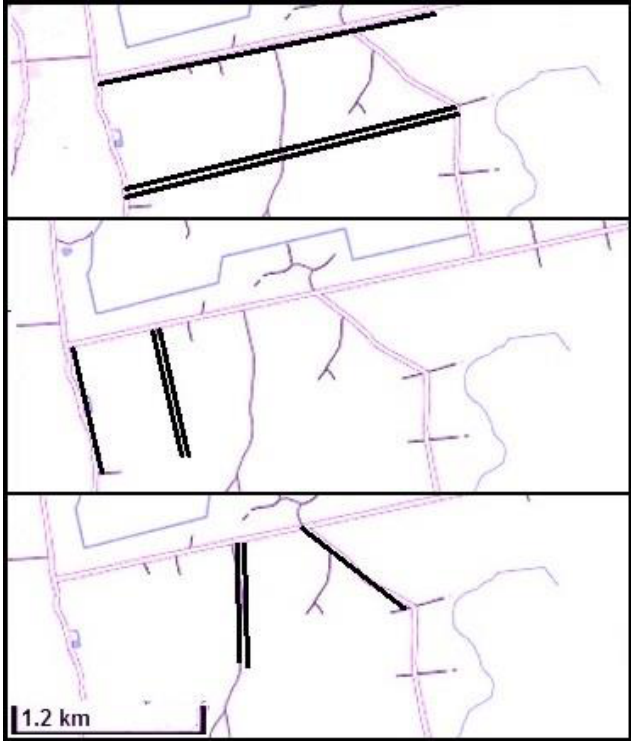
Fig. 2. Study area. One line shows forest road, two lines -